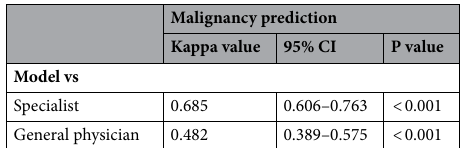
Table 3. Agreement of the model and human